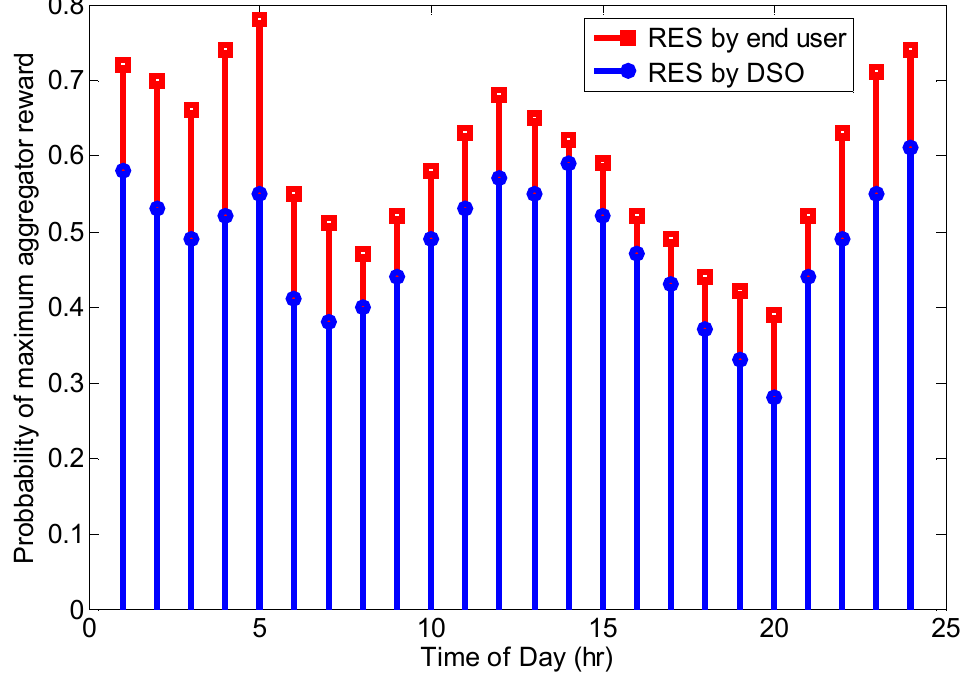
Figure 7. Plot of probability of maximum aggregator reward based on the Bayesian network for DSO and end user utilization of RES.